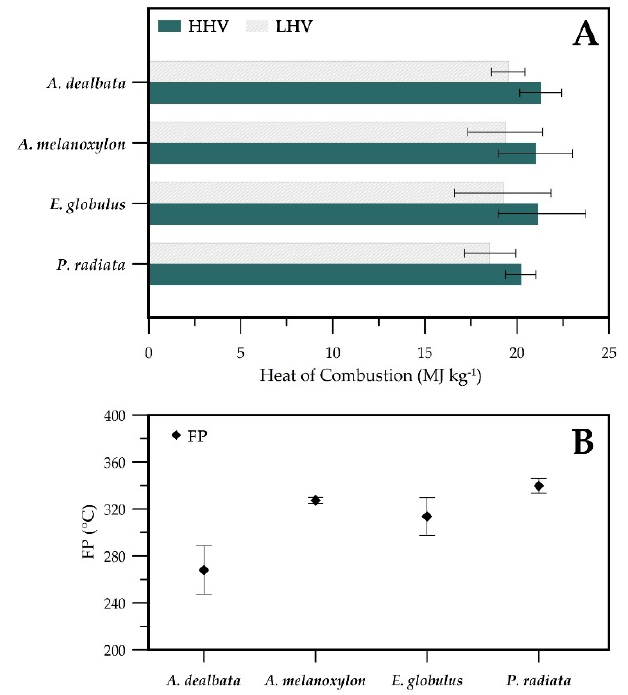
Figure 3. Thermochemical properties of exotic species analyzed during summer 2020–2021: ( A ) higher heating value (HHV) and lower heating value (LHV); and ( B ) flashpoint (FP). Horizontal bars and solid diamond points represent mean values, while the error bounds correspond to the standard deviation of the data set.